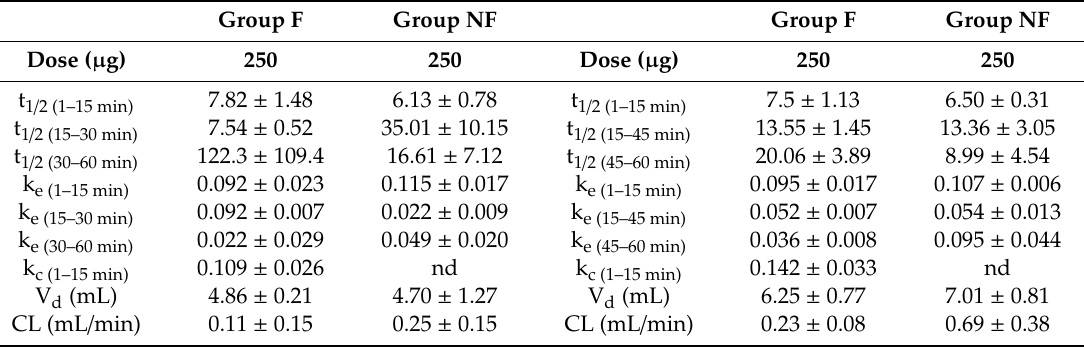
Table 1. Pharmacokinetic parameters of 6-deoxy-6-[(5 / 6)-fluoresceinylthioureido]-(2-hydroxypropyl)- β - cyclodextrin (FITC-HPBCD), administered intravenously to mice.